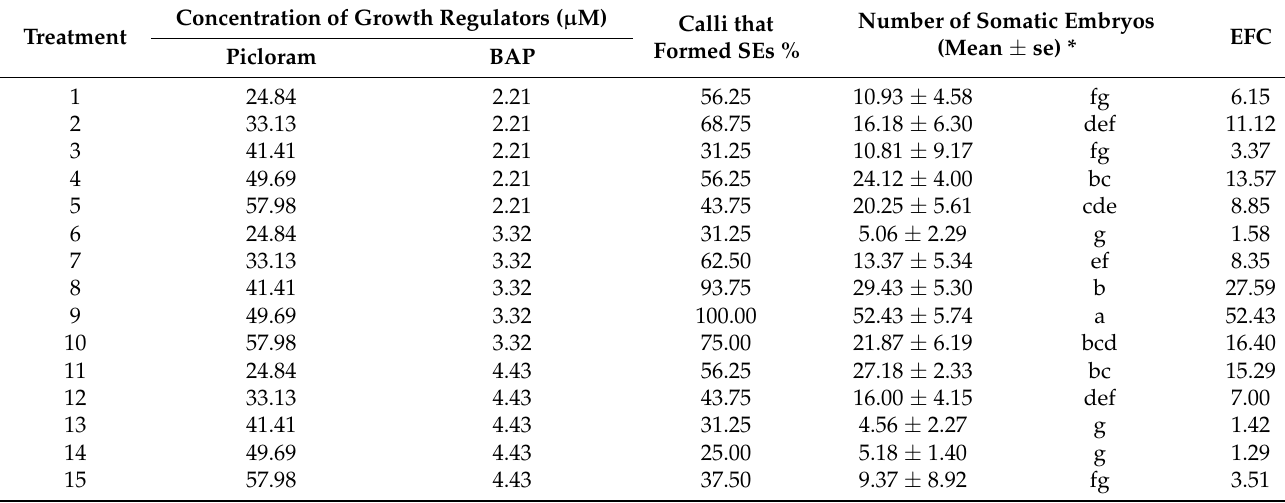
Table 1. Effect of plant growth regulators on the differentiation rate of somatic embryos derived from calli of in vitro young leaves of Agave tequilana